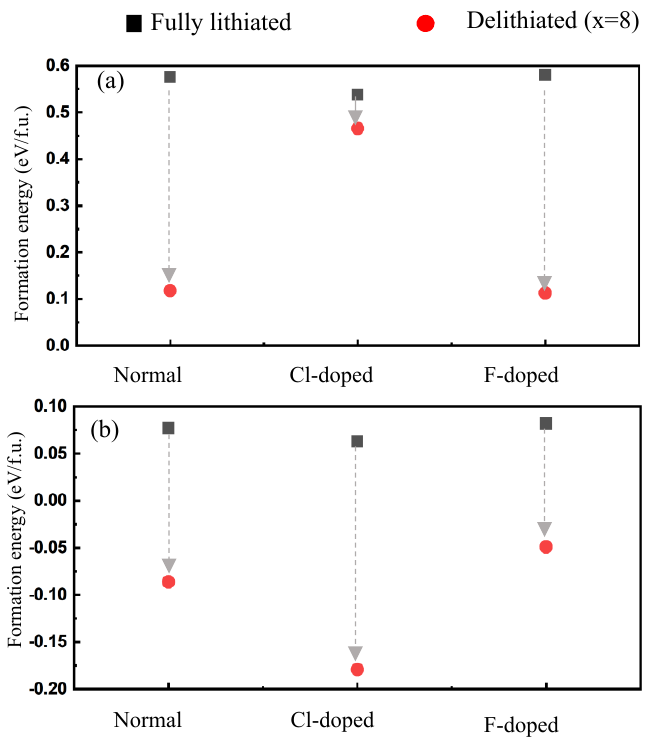
Figure 10. Defect forming energy: ( a ) V O ; ( b ) Li Ni Ni Li.